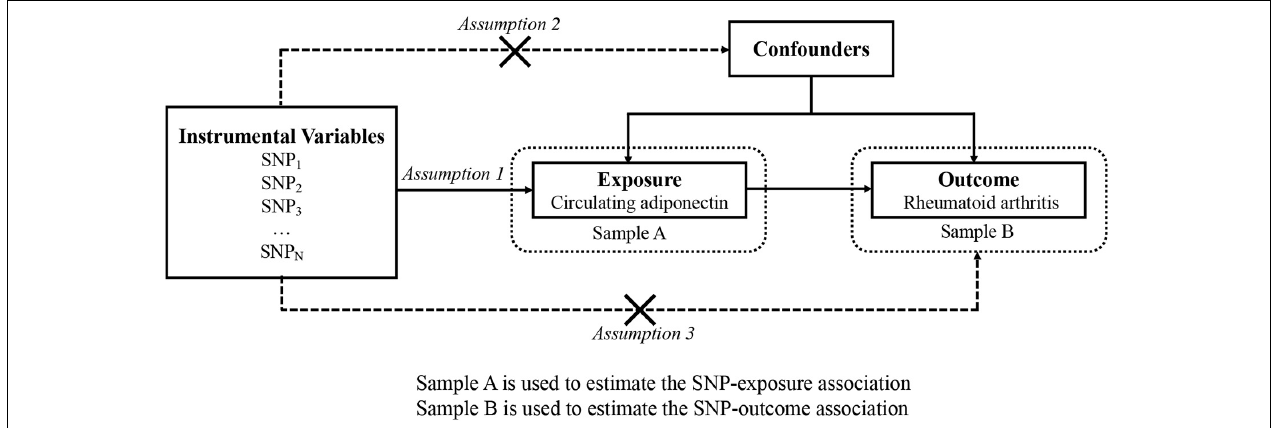
FIGURE 1 | An overview of the study design with three fundamental assumptions about MR